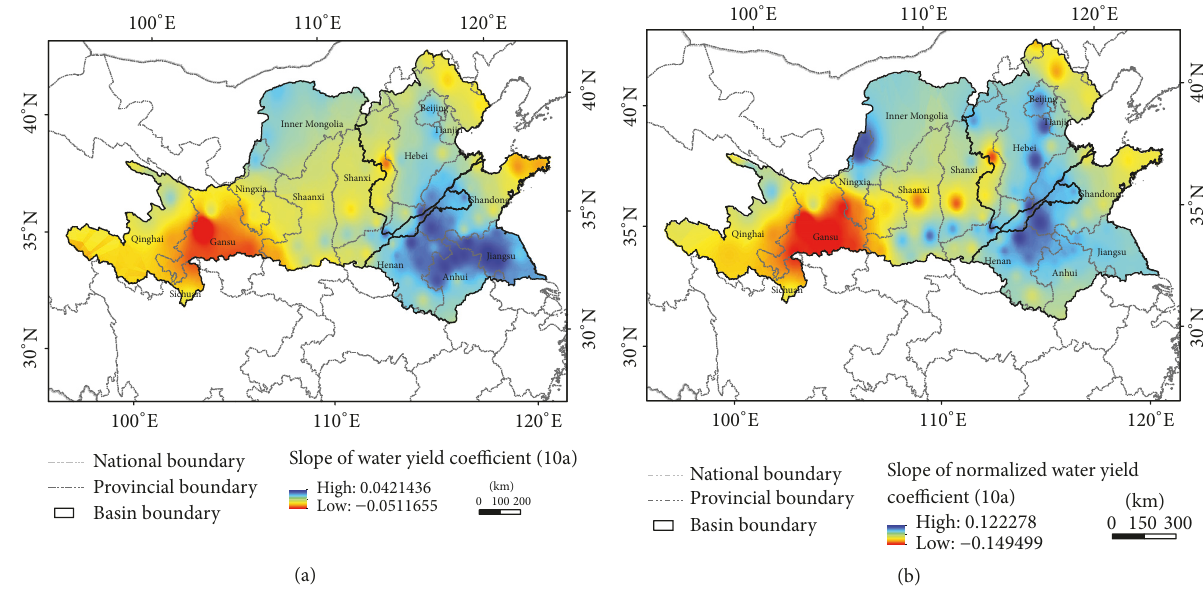
Figure 2: (a) Trend of the actual WYC from 1961 to 2011. (b) Trend of the normalized WYC from 1961 to 2011.